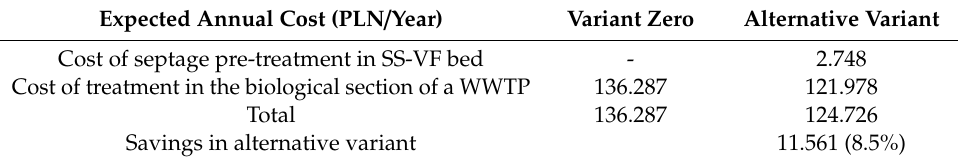
Table 1. Example 1—comparison of costs in variant zero and in alternative variant.